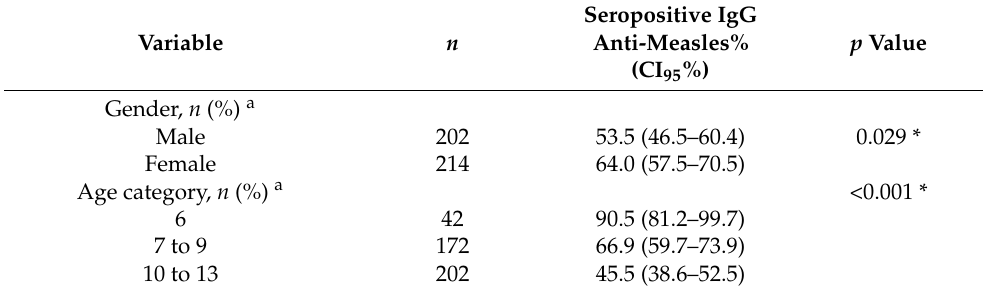
Table 3. Relationship measles antibodies according to socio-demographic data in total